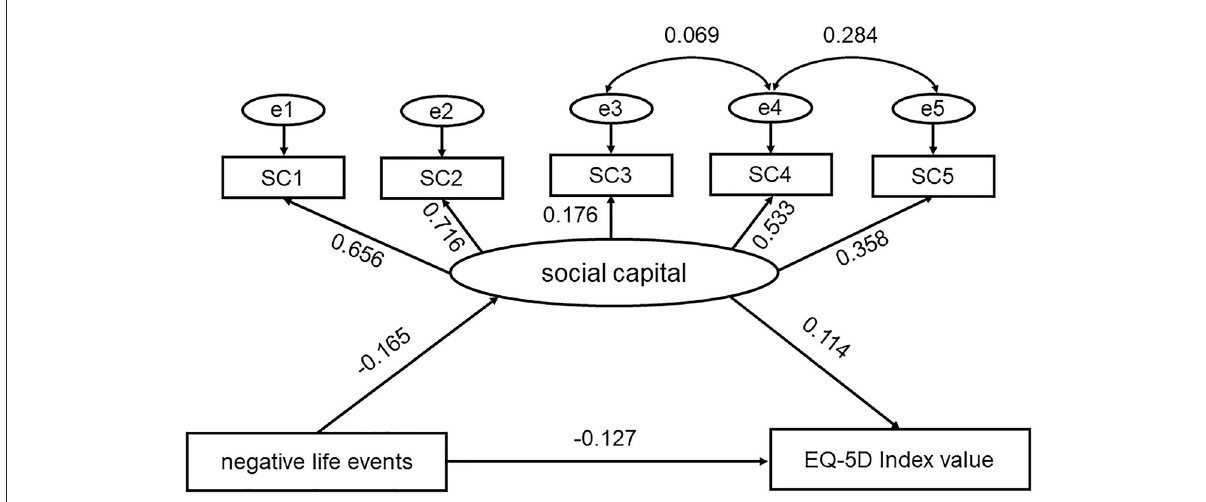
FIGURE3 Conceptual model of the impact of social capital and negative life events on EQ-5D index value. SC1 ∼ SC5 represent five items in the brief social capital scale.